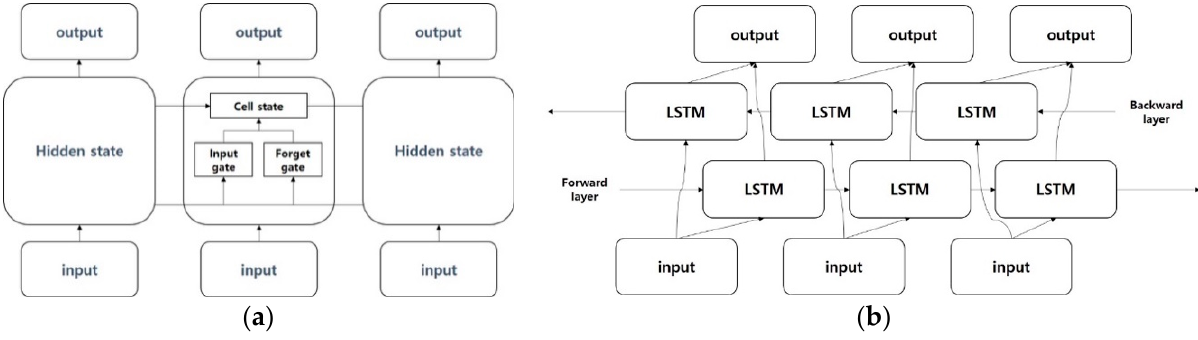
Figure 6. ( a ) Gated recurrent unit (GRU) model; ( b ) bidirectional LSTM